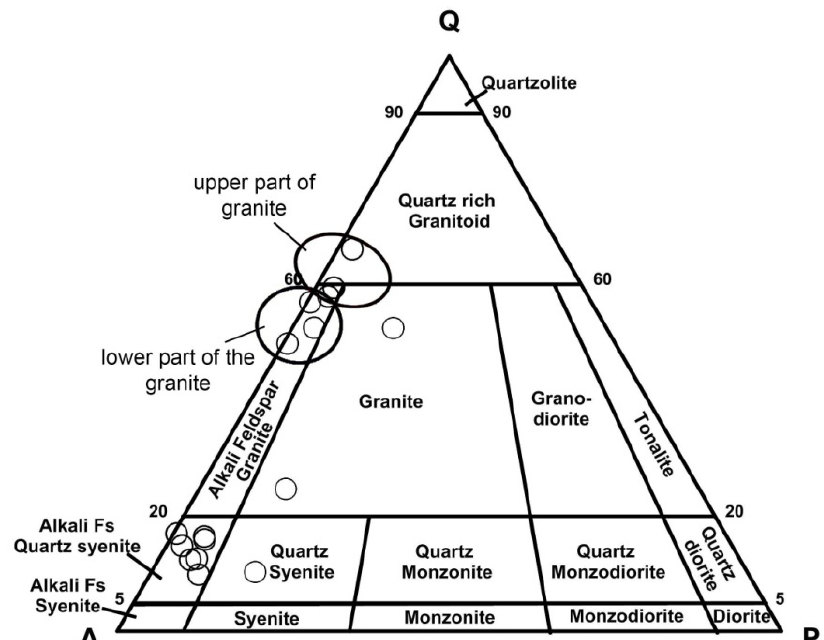
Figure 3. Quartz, alkali feldspar and plagioclase (QAP) diagram (Streickeisen, 1974) showing mineral modal abundance of the syenite and granite of the Khaldzan Burgedei complex.